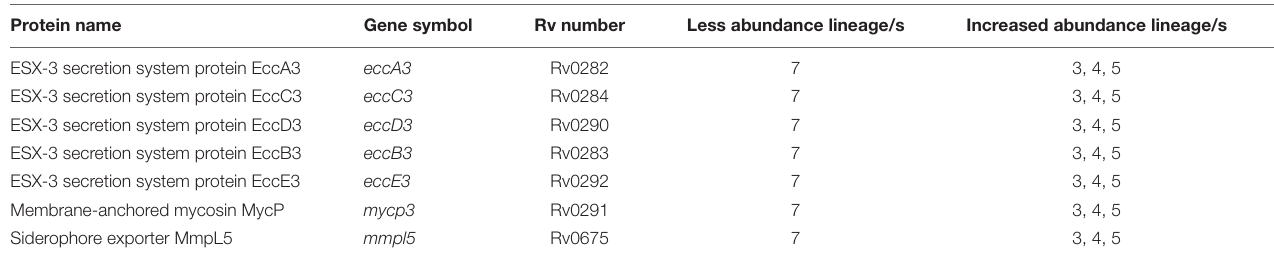
TABLE 1 | Differentially abundant proteins in the type VII ESX-3 secretion systems in MTBC